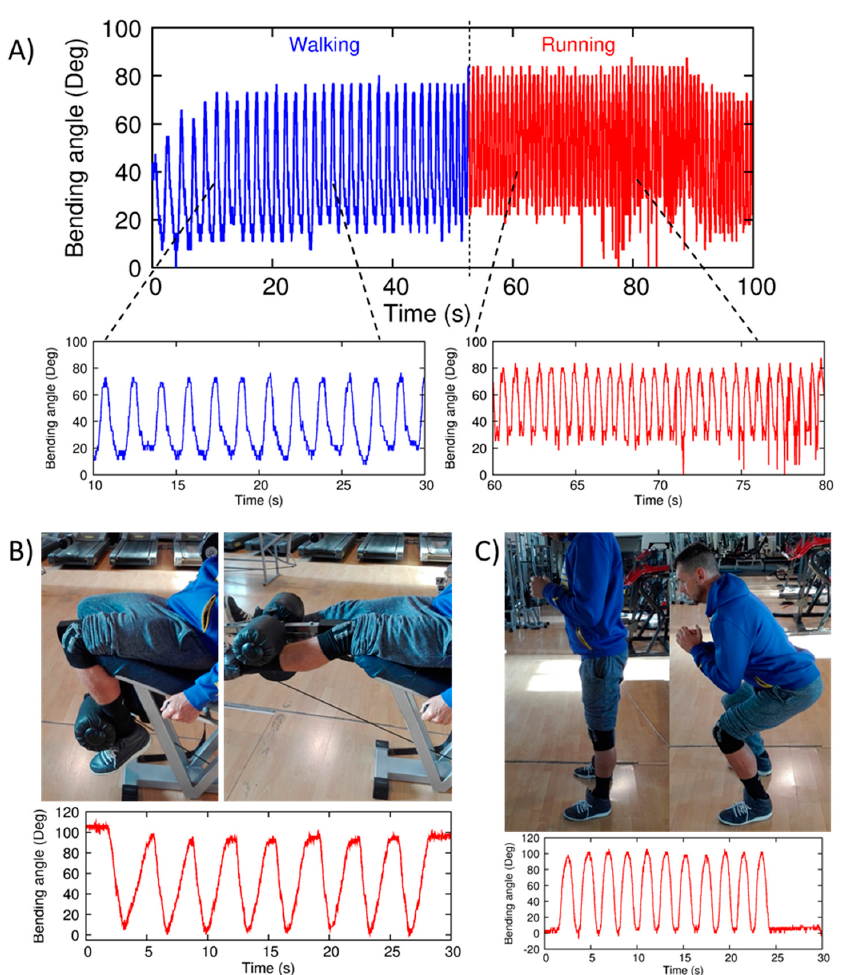
Figure 16. Knee monitoring during different tasks: ( A ) Walking/running on a treadmill; ( B ) Leg- extension exercises; ( C ) Squat exercises.